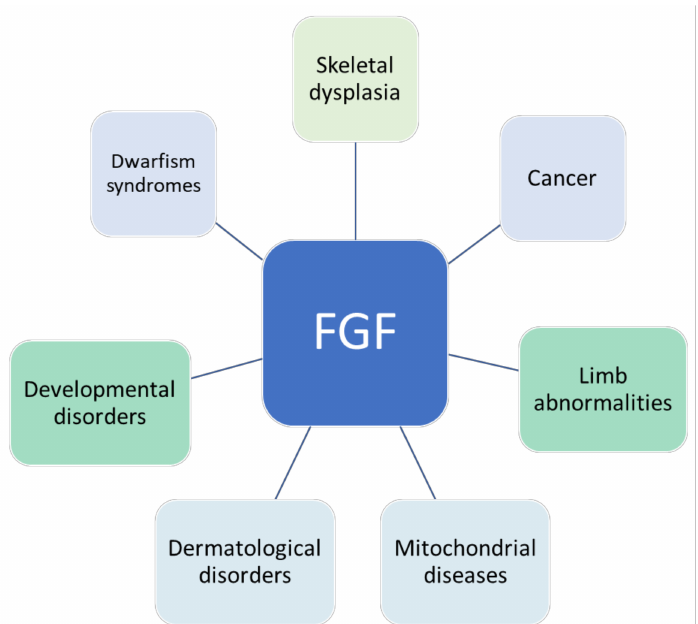
Figure 1. Diseases associated with FGFs dysregulations. Abnormalities in FGF signaling can lead to dwarfism syndrome [19], skeletal dysplasia [20], limb abnormalities [21], mitochondrial diseases [9], cancers, skin diseases [22], and developmental disorders